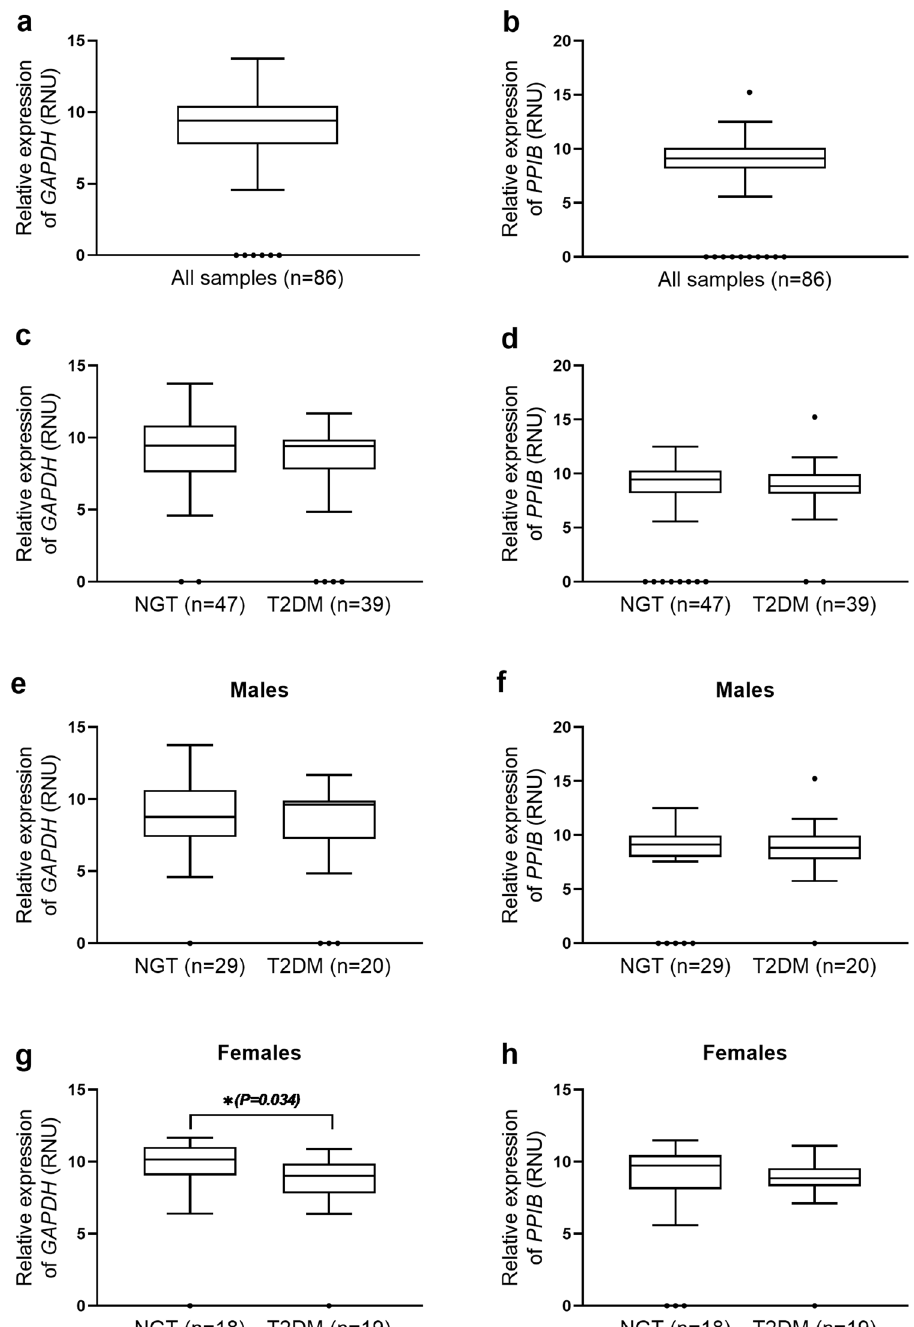
Figure 4. Boxplots of relative expression of GAPDH and PPIB expressed as relative normalization units (RNU) with ACTB and YWHAZ as reference genes, in all study samples (n = 86); NGT group (n = 47); T2DM group (n = 39); male NGT (n = 29) and T2DM (n = 20) subjects and female NGT (n = 18) and T2DM (n = 19) subjects. Relative expression of GAPDH in all study samples ( a ) , NGT and T2DM groups ( c ) , in male NGT and T2DM subjects ( e ) and in female NGT and T2DM subjects ( g ). Relative expression of PPIB in all samples ( b ), in NGT and T2DM groups ( d ) , in male NGT and T2DM subjects ( f ) and in female NGT and T2DM subjects ( h ). Outliers are represented as dots “(black shaded circle)”. The median values are represented as lines across the box. The lower and the upper boxes represent the first and third quartile, respectively. Whiskers represent the maximum and minimum value. P values are from Mann Whitney test. Calculation of relative expression for GAPDH and PPIB as target genes was done based on a modification of the ΔCt method using ACTB and YWHAZ as reference genes; [ΔCt = Ct (target gene) —Ct (Reference genes mean) ]. RNU was calculated as, RNU = 15−ΔCt 43